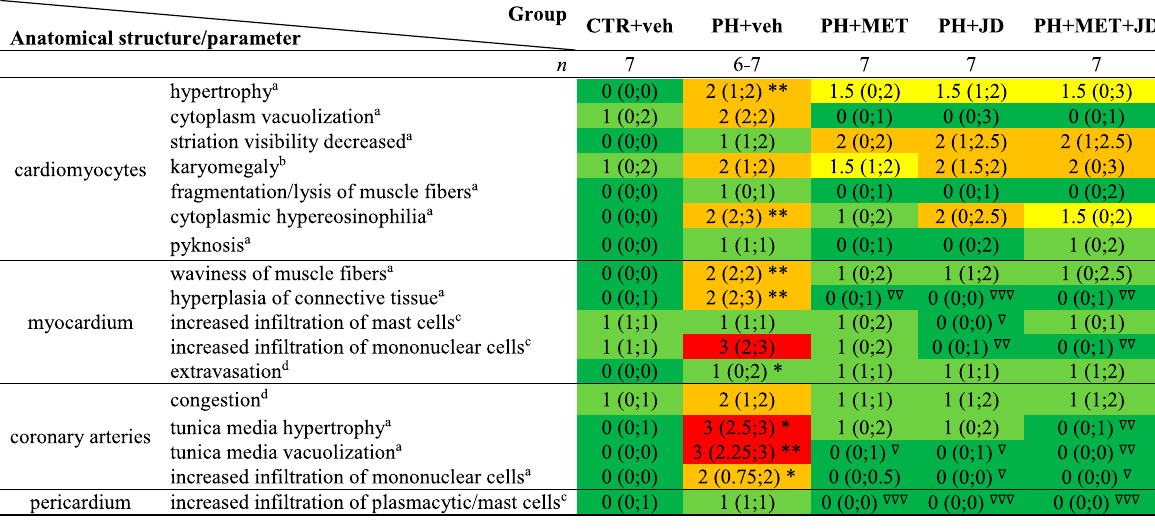
MET(100 mg/kg),JD5037(3 mg/kg)ortheircombinationwereadministeredbyoralgavageoncedailyfor21days;controlsreceivedvehicles(veh)instead.Dataarebasedon6-7ratsper group and are expressed as median of scores ranging from 0 to 4 with an interquartile range. * p < 0.05, ** p < 0.01 signi fi cantly different from CTR + veh. ∇ p < 0.05, ∇∇ p < 0.01, ∇∇∇ p < 0.001 signi fi cantly different from PH + veh. The colors correspond to the median values of the scoring of the group: dark green (0), light green (1), yellow (1.5), orange (2) and red (3). a Scoring scale type B5: 0 — no pathological changes; 1 — minimal disruptions in architecture/structure, ×40 objective; 2 — moderate disruptions in architecture/structure, ×40 objective; 3 — minimal/mild disruptions in architecture/structure, ×10 objective; 4 — moderate/marked disruptions in architecture/structure, ×10